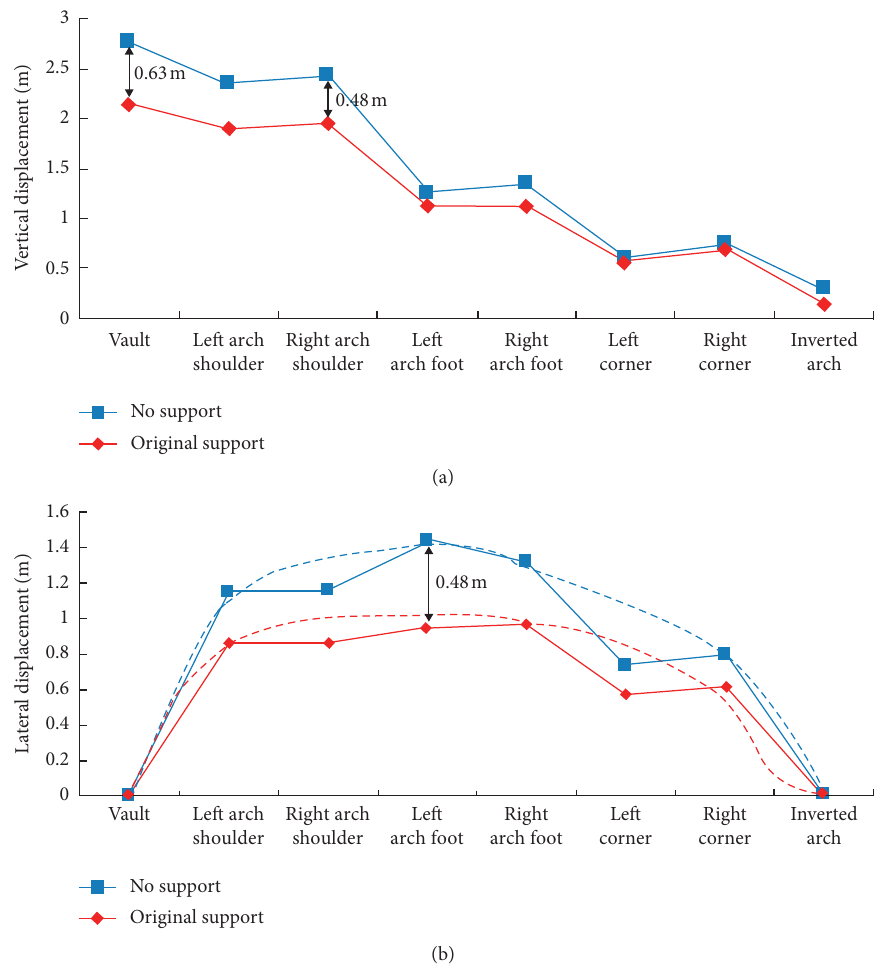
Figure 4: Trend diagram of displacement of each measuring point in the tunnel. (a) Z -direction displacement of each measuring point. (b) X -direction displacement of each measuring